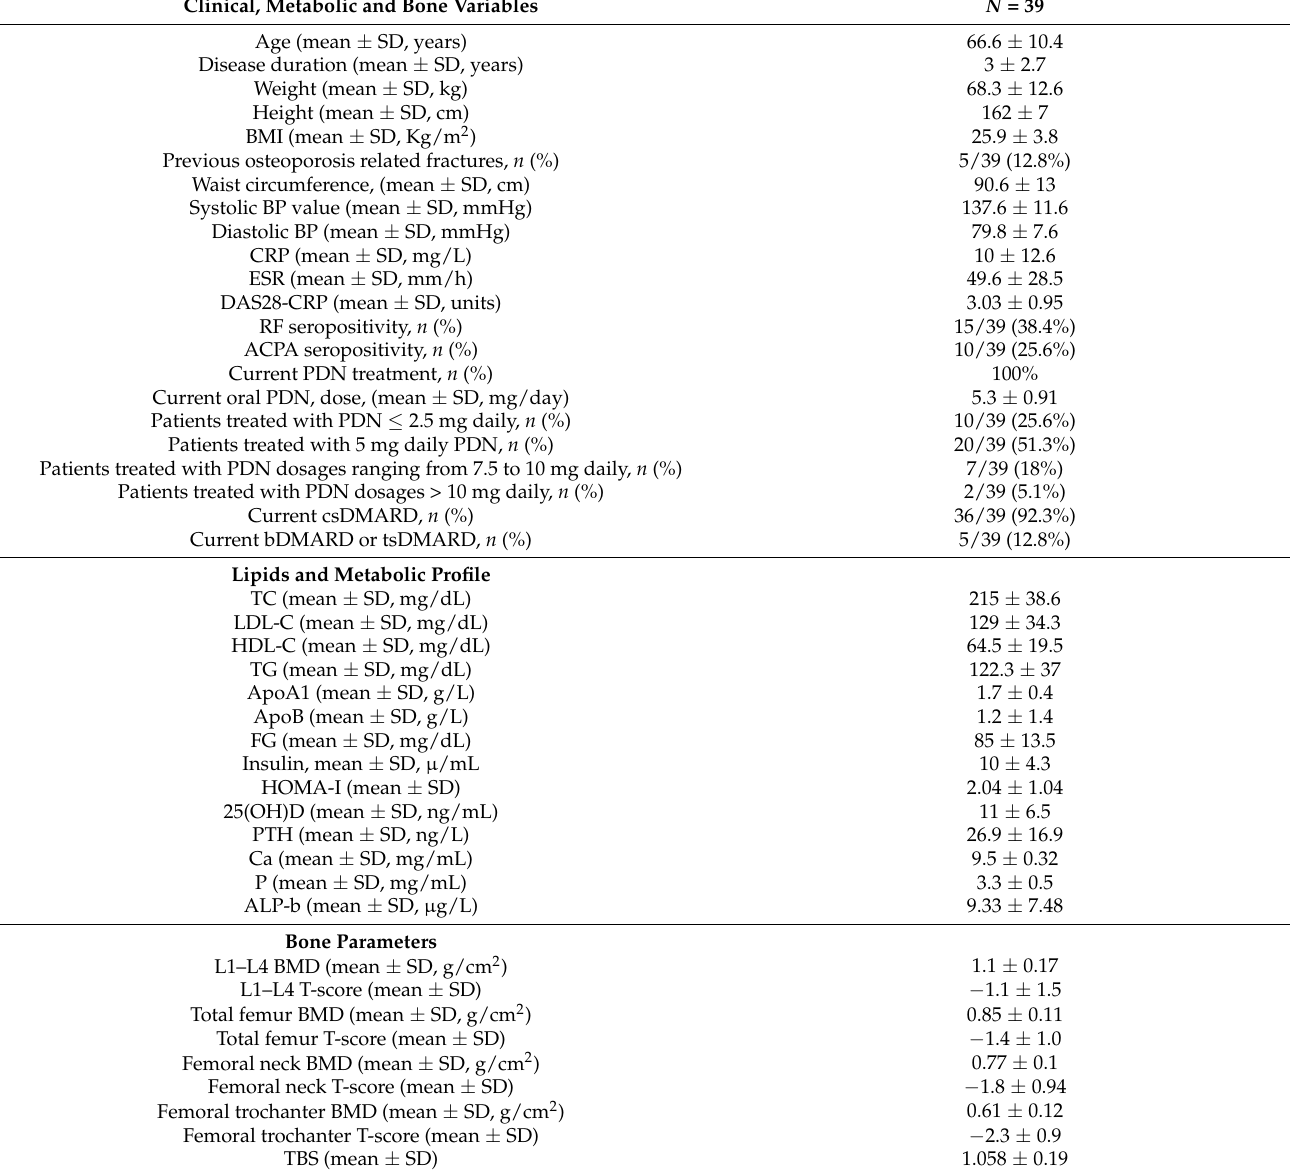
Table 1. Clinical, metabolic, and bone parameters of the whole cohort of RA patients. Clinical, Metabolic and Bone